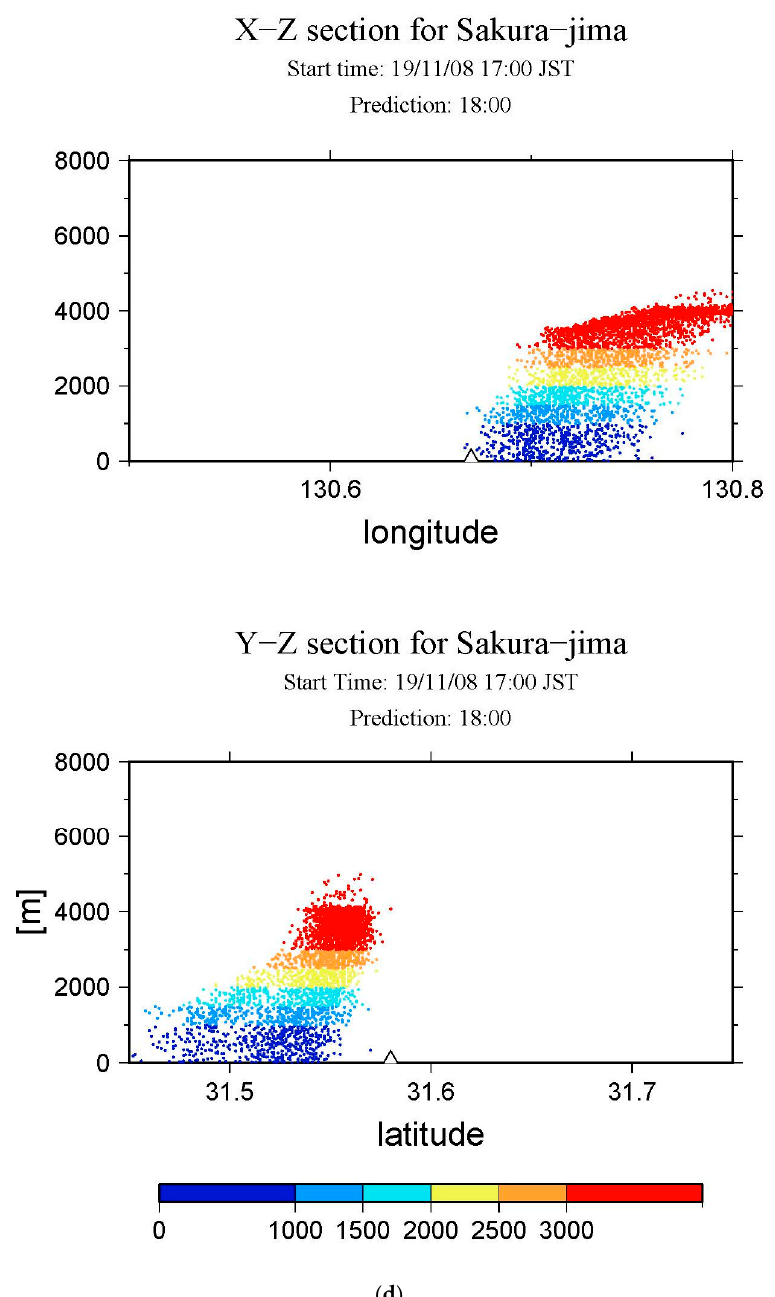
Figure 9. Ash plume dispersal in zonal-height (X-Z) and meridional-height (Y-Z) cross sections as in Figure 4, but using the MP radar data for ( a ) 17:30, ( b )17:40, ( c ) 17:50, and ( d ) 18:00 JST, respectively.